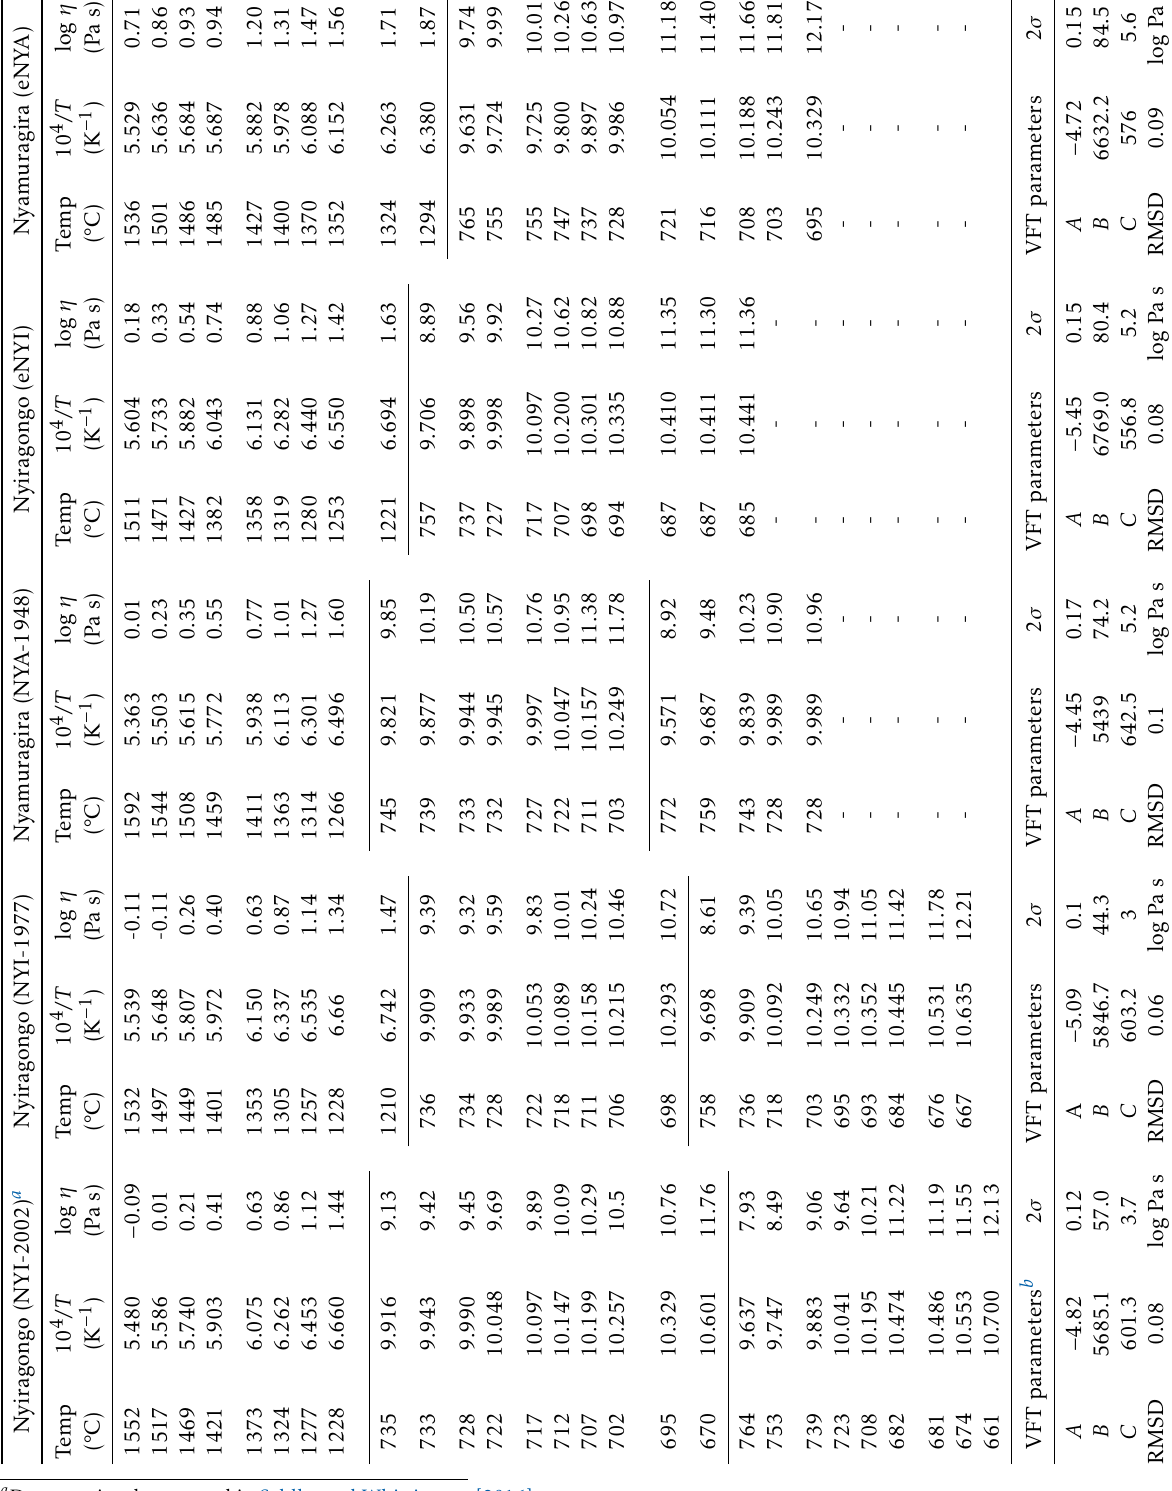
Table 3 – Crystal free, liquid viscosity measurements above the liquidus and near the glass transition of remelted glass and evolved glass materials. Lines separate di ff erent viscosity